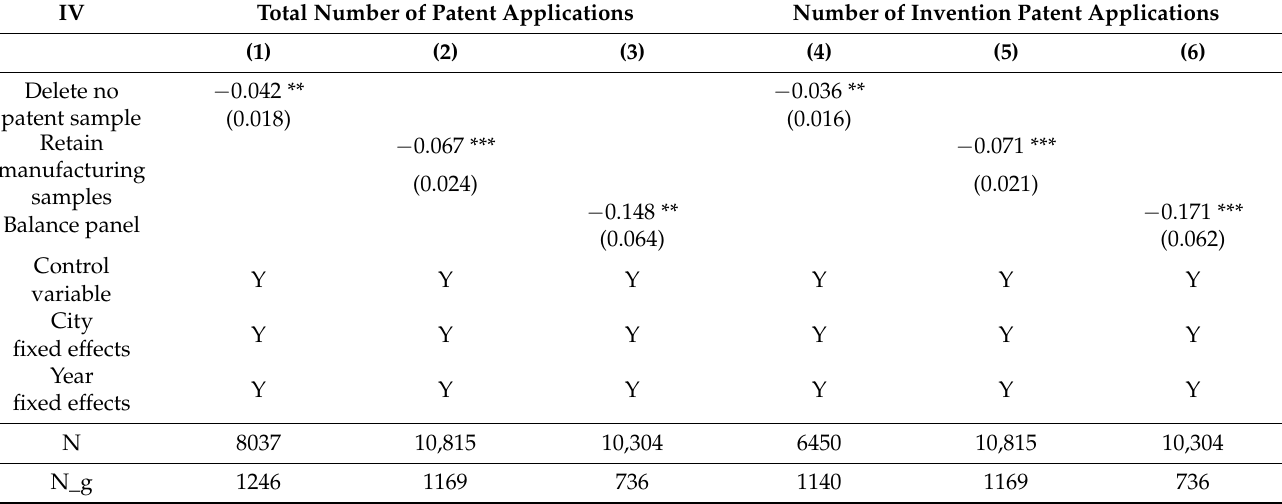
Table 5. Robustness test